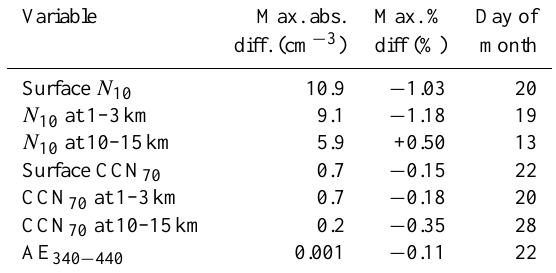
Table 4. The maximum absolute difference between unperturbed and perturbed data averaged over the 12 months, as both an absolute value and a percentage, as well as the day of the month on which the maximum difference